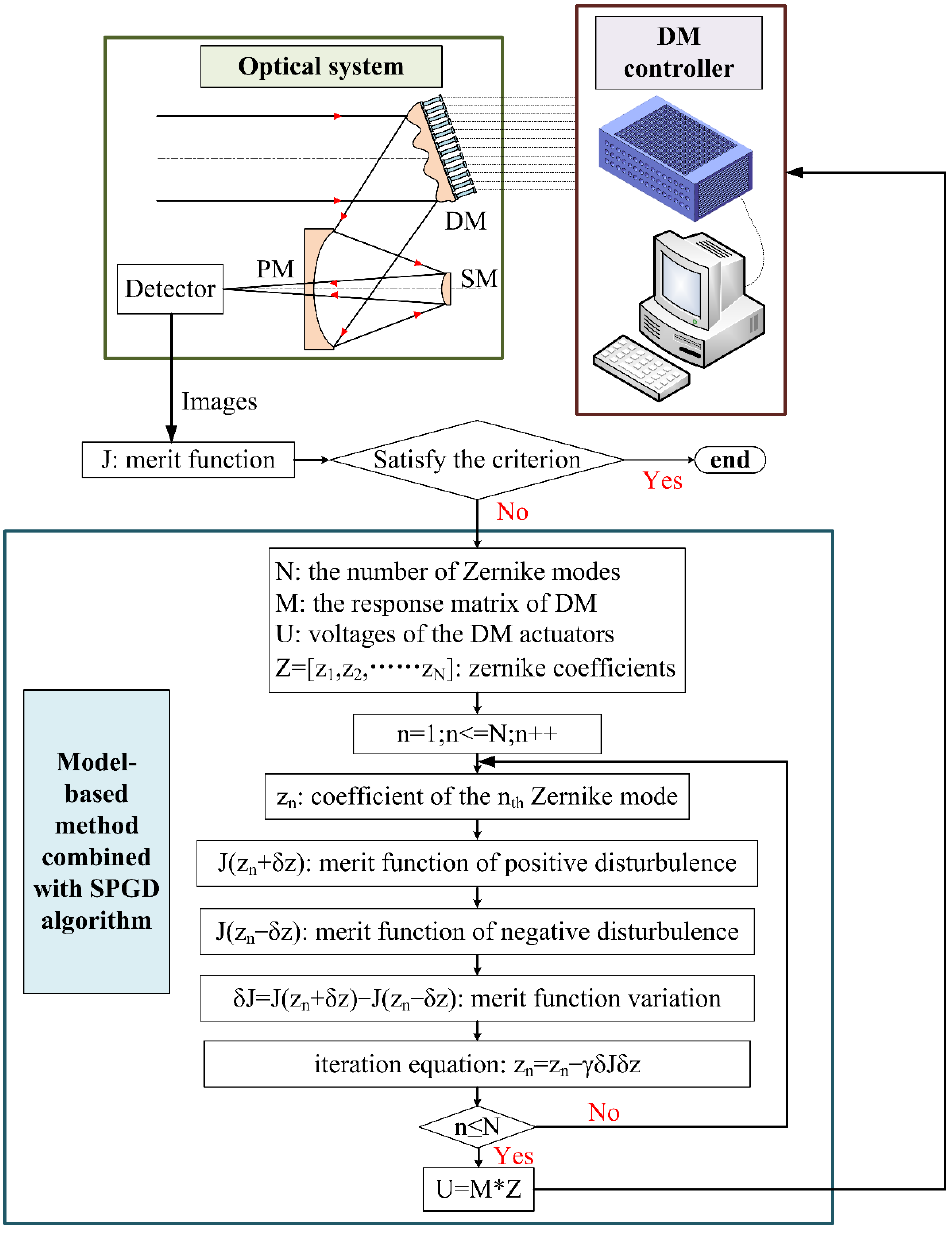
Figure 5. The experiment system and correction processes.